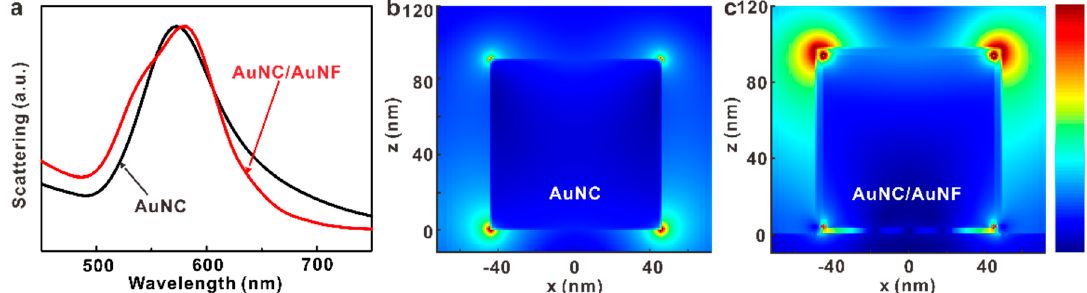
Figure 5. Numerical simulations. ( a ) The calculated scattering spectra of an AuNC (black curve) and AuNC with a 4 nm thick dielectric coating layer on the AuNF substrate (red curve). The side length of AuNC is 90 nm and the refractive index of the dielectric coating layer is set at 1.6. ( b ) and ( c ) Electric field distributions of the structures of ( b ) pure AuNC and ( c ) AuNC on AuNF.